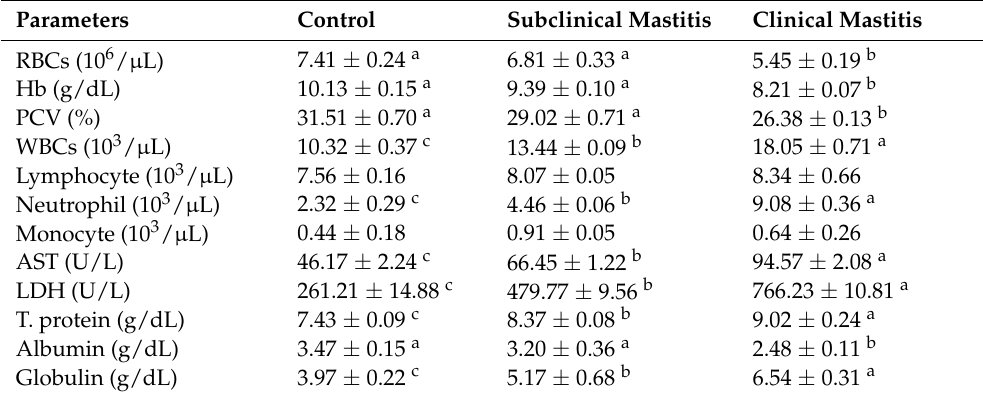
Table 4. Hematological and serum biochemical parameters of dairy cows with subclinical and clinical mastitis.